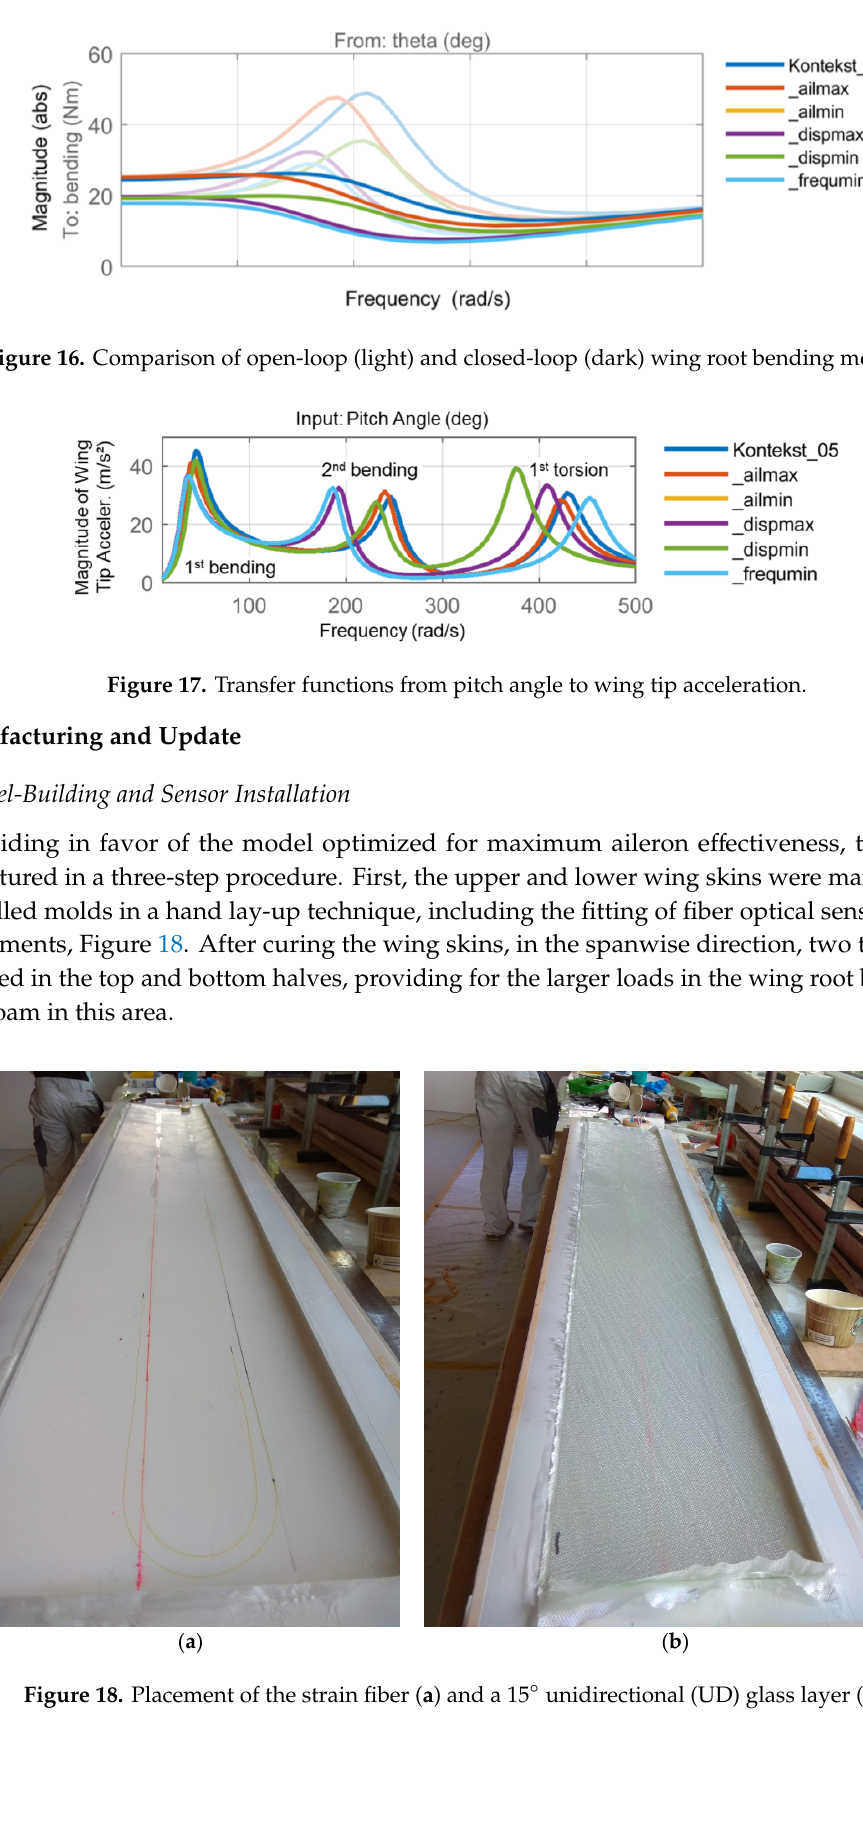
Figure 18. Placement of the strain fiber ( a ) and a 15° unidirectional (UD) glass layer ( b ).